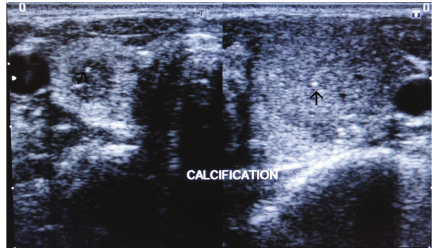
Figure 4: Axial contrast enhanced CT images of abdomen taken at the level of adrenals showing large round heterogeneous lesions in bilateral adrenals with left adrenal lesion showing central necrosis and fluid-fluid level. Central hypodense nonenhancing area is suggestive of necrosis with intense peripheral